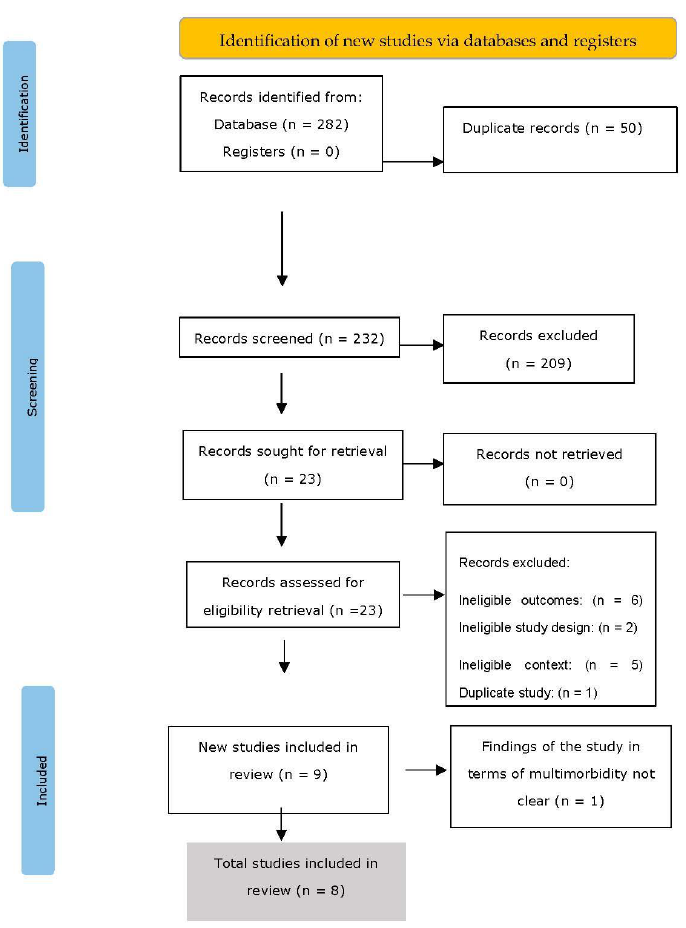
Figure 1. PRISMA (Preferred Reporting Items for Systematic reviews and Meta-Analyses) flowchart of the literature search.